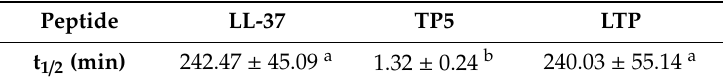
Table 2. Half-life of LTP in